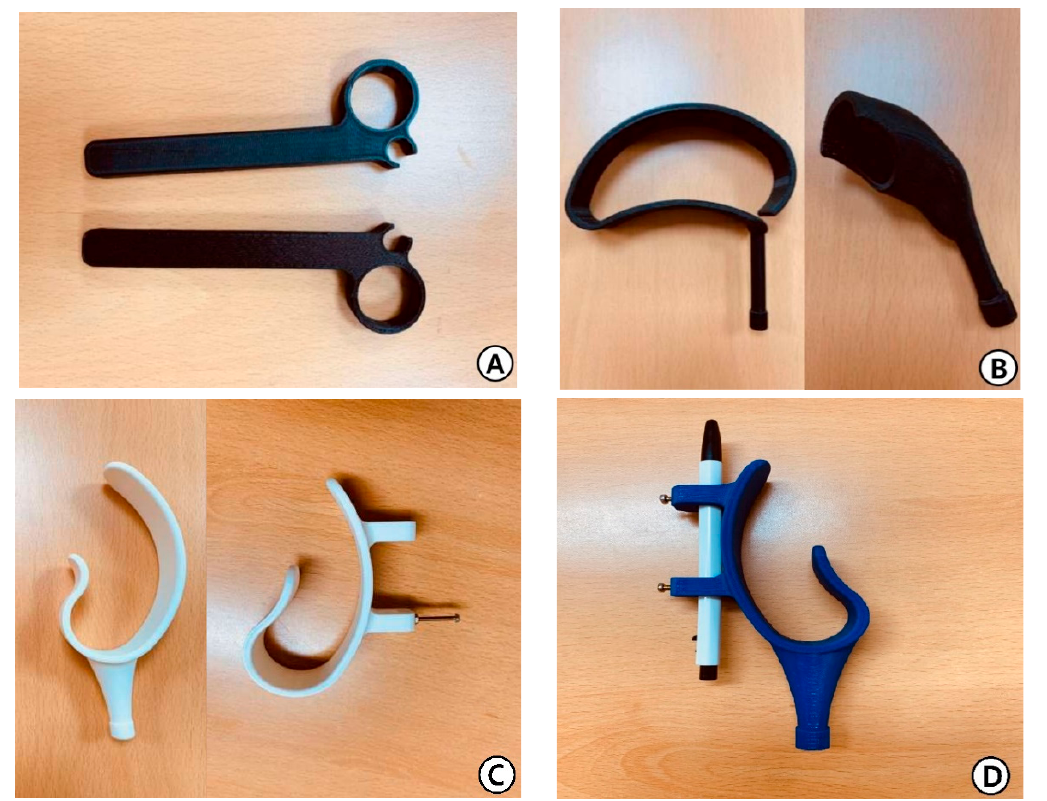
Figure 1. ( A ) First 3D-printed writing device. ( B ) First 3D-printed typing device. ( C ) Second 3D- printed writing ( left ) and typing ( right ) device. ( D ) Third 3D-printed typing and writing integration device.